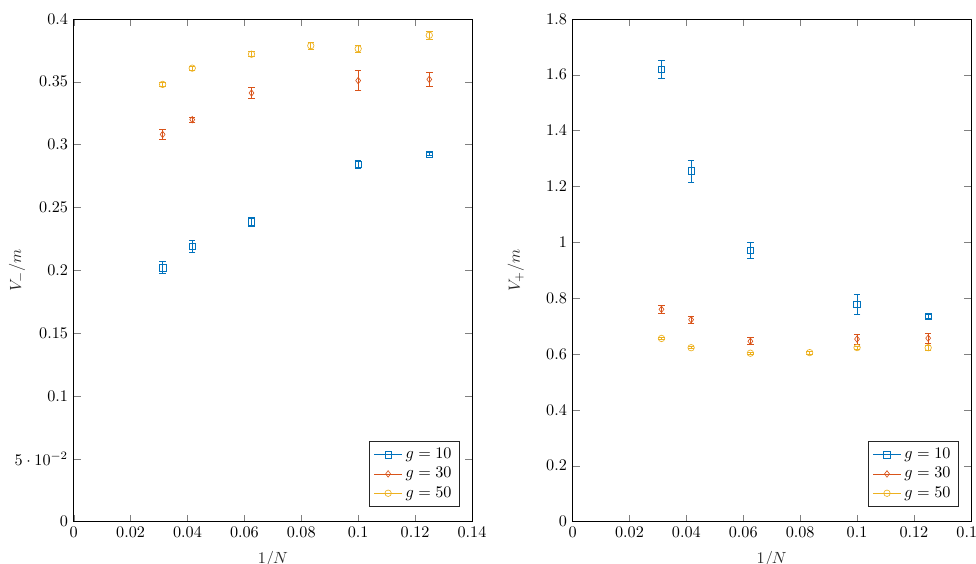
Figure 5 . The exponential decays resulting from the (cid:12)t of the Monte Carlo data for the fermionic correlators C sum to (4.36) for g = 10 ; 30 ; 50 and various values of N